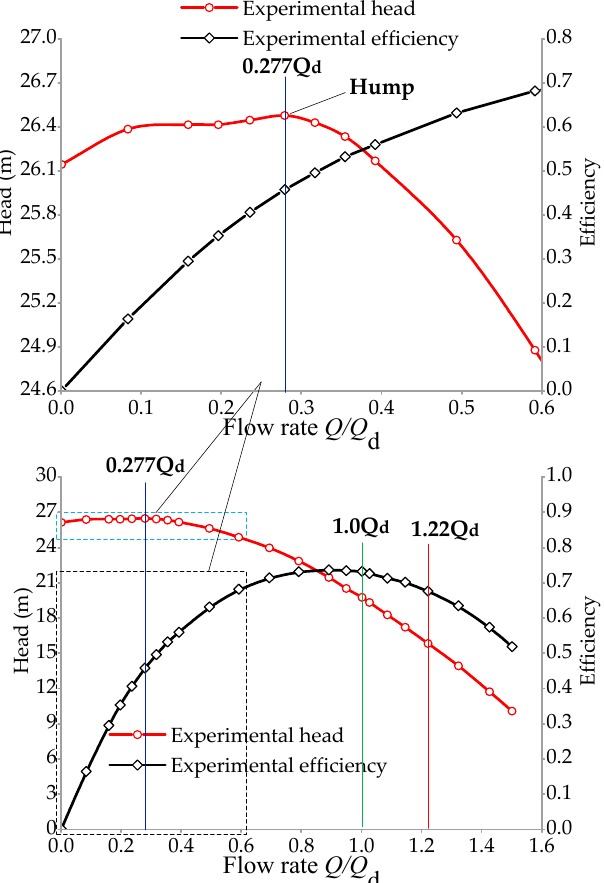
Figure 6. Performance curves of the centrifugal pump.